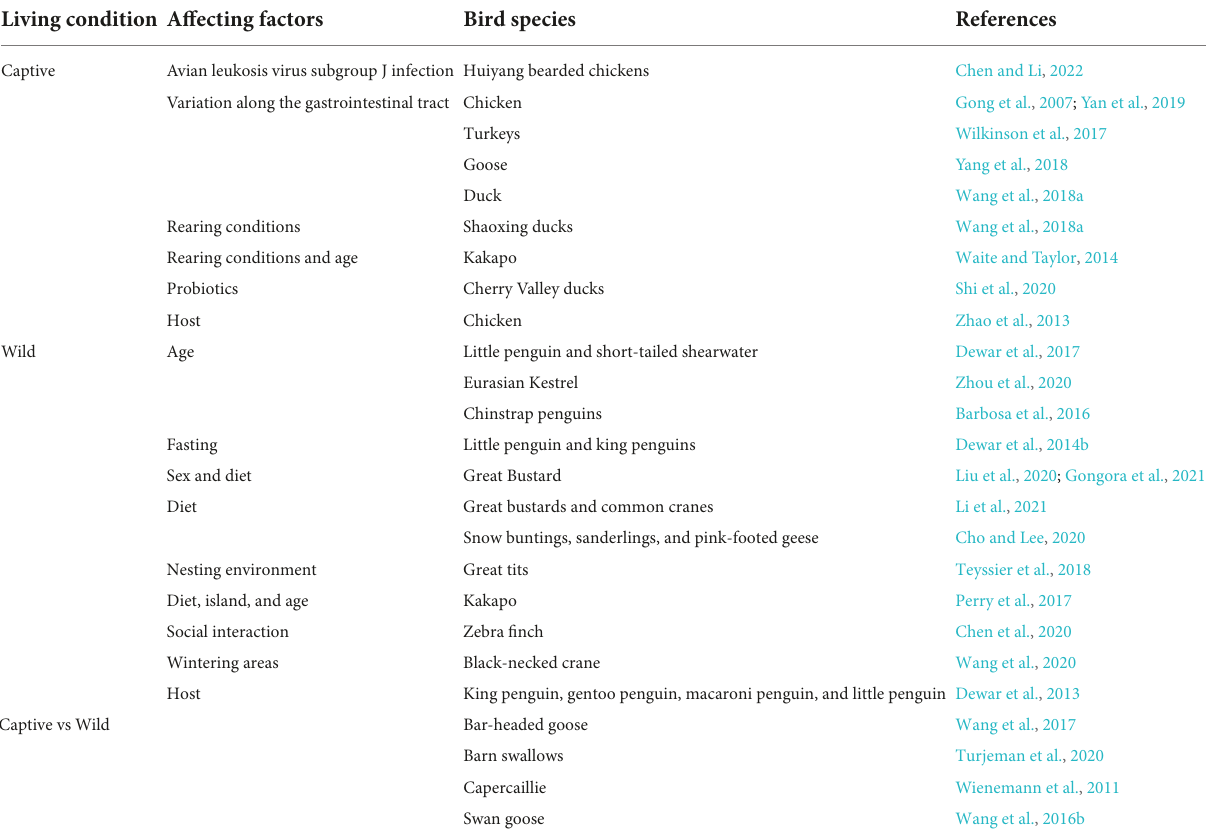
TABLE 1 Influencing factors affecting avian gut microbiota in different living